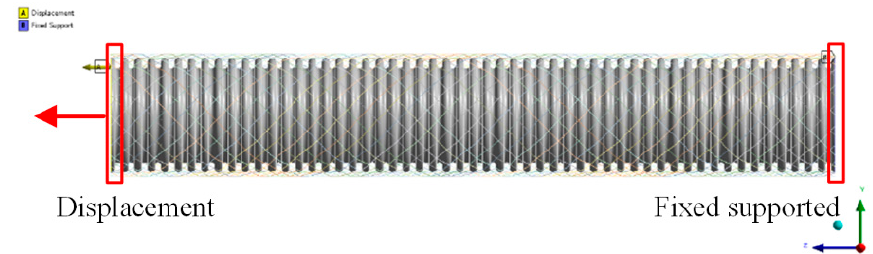
Figure 9. Finite element model.